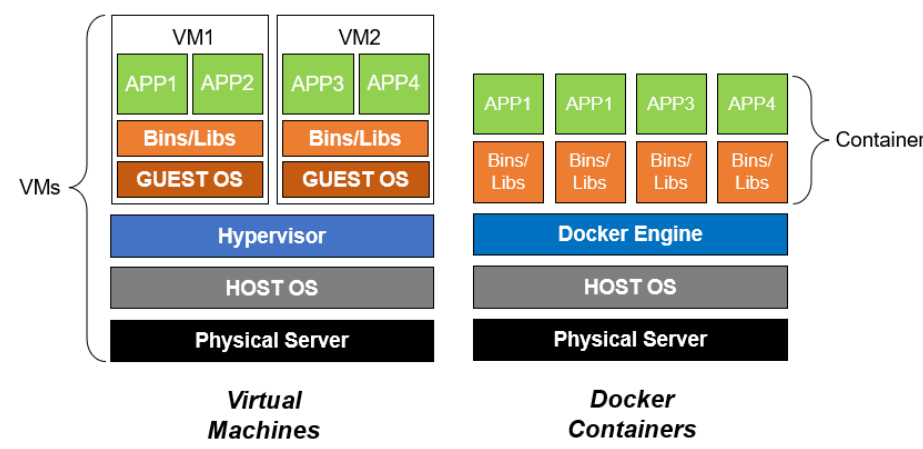
Figure 1. Virtual machines vs.